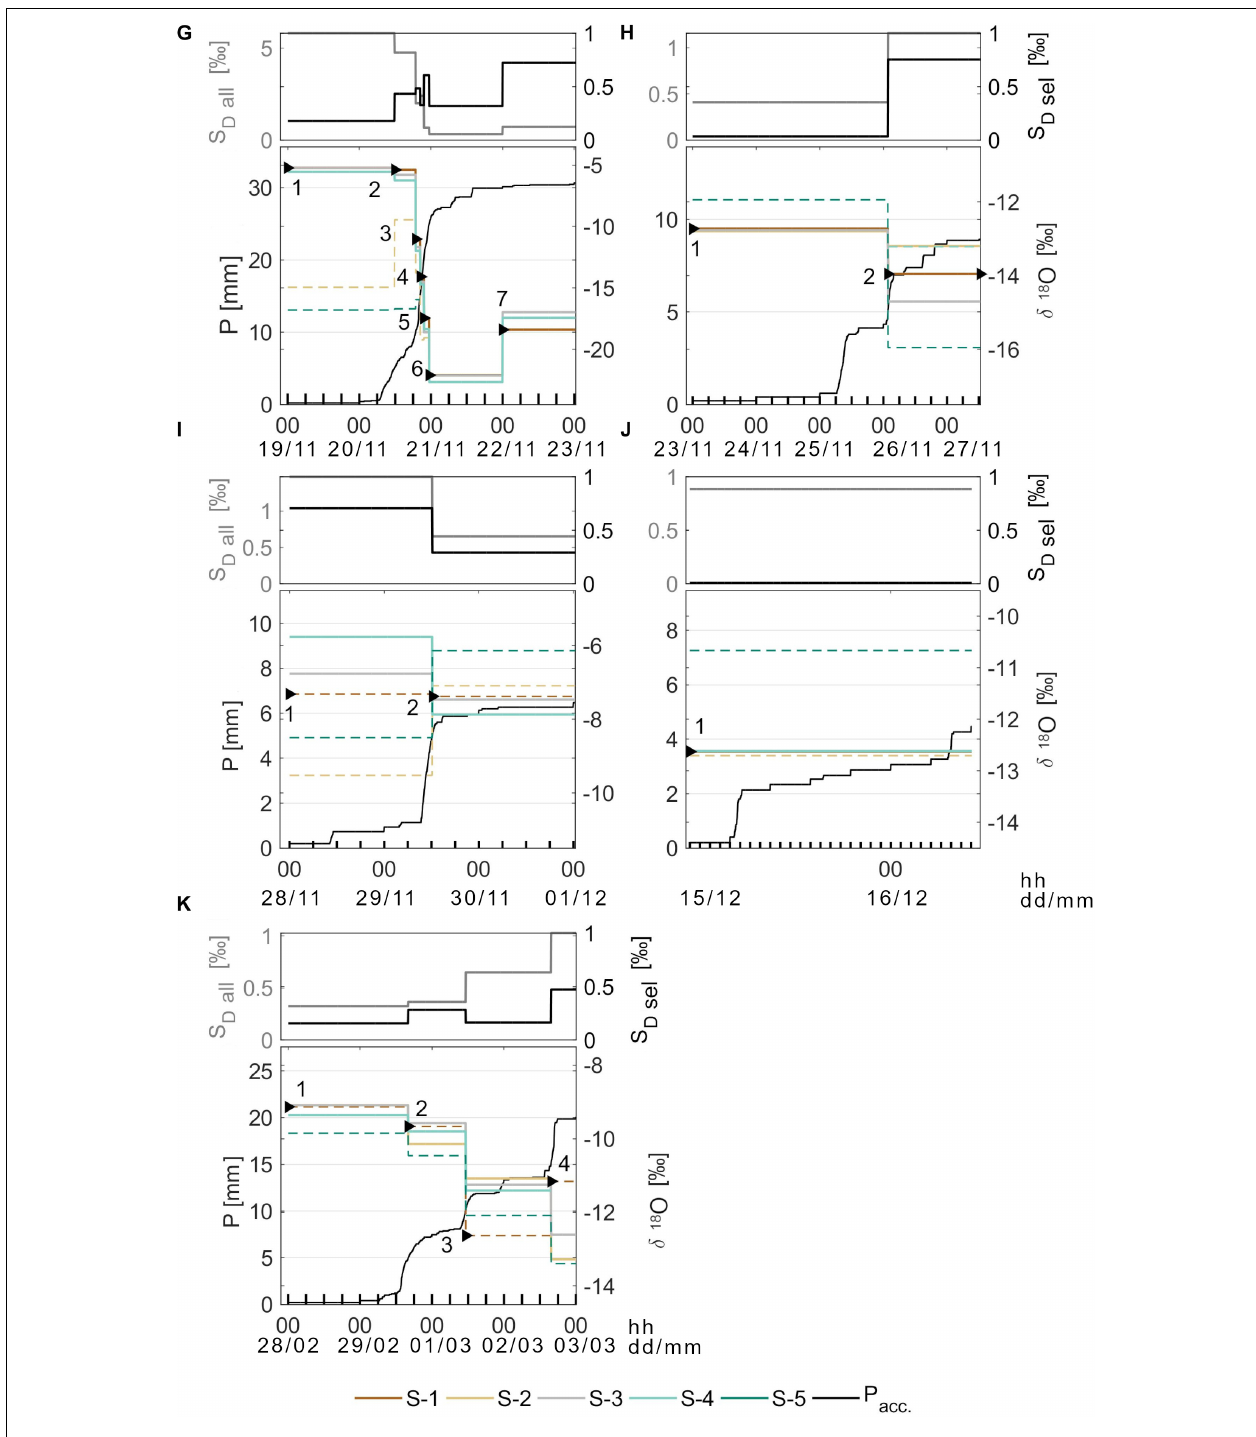
FIGURE 2 | For the 11 rainfall events (A–K) , the mean accumulated rainfall (black line, left axis) and the δ 18 O of rainfall (5 mm increments) of the different rain samplers (S-1 to S-5; colored lines). The triangles indicate the start of a new bottle which are consecutively numbered number 1 to n . The solid lines indicate a correct δ 18 O sample while a dashed line indicates δ 18 O samples, for which the rain samplers malfunctioned due to technical problems. On top of each panel the temporal evolution of the S D δ 18 O all rain samplers (gray line, left y -axis) and S D δ 18 O sel rain samplers excluding malfunctioning rain samplers (black line, right y -axis).